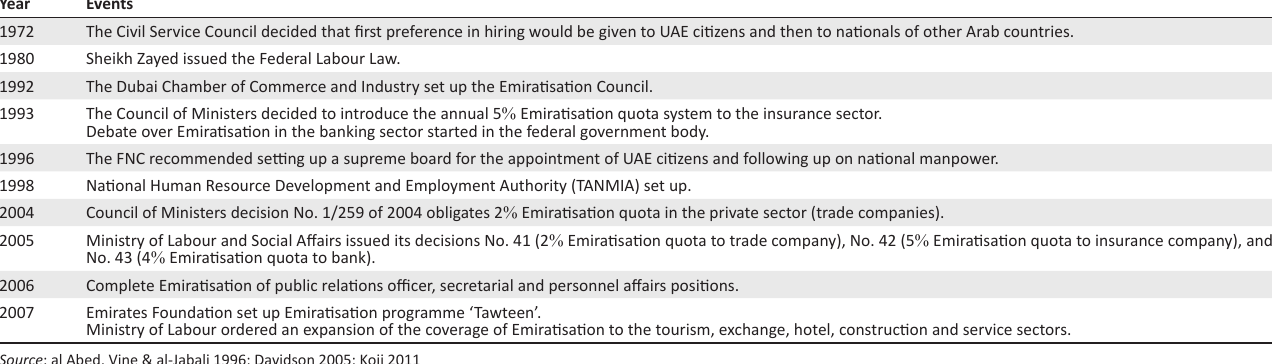
TABLE 2: Chronology of labour market reform initiatives in the